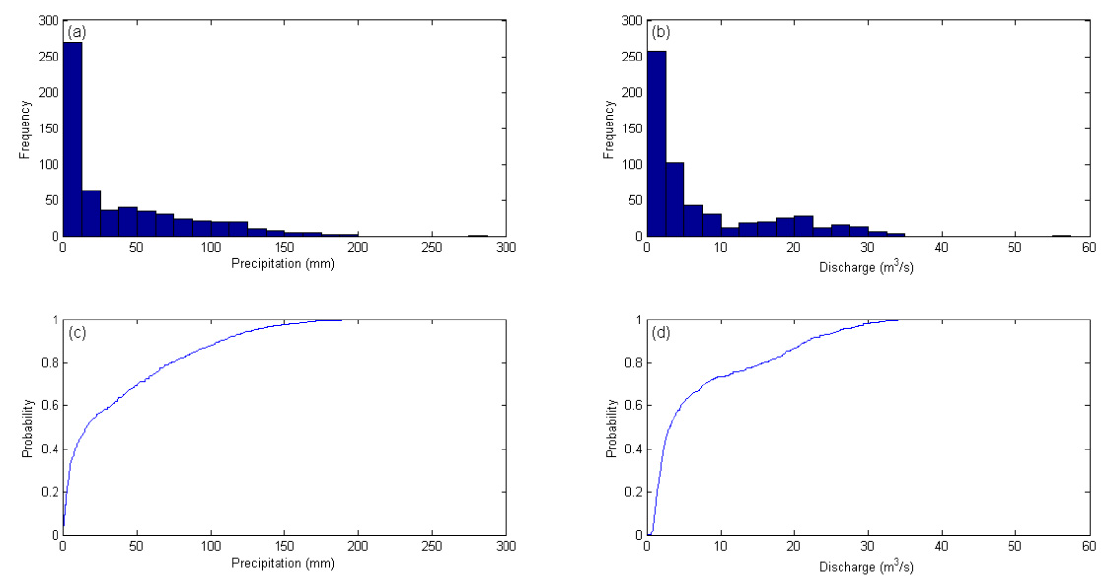
Figure 4. The histograms and empirical distribution functions of the samples of precipitation and discharge. ( a ) histogram of precipitation, ( b ) histogram of discharge, ( c ) empirical distribution function of precipitation, ( d ) empirical distribution function of discharge.